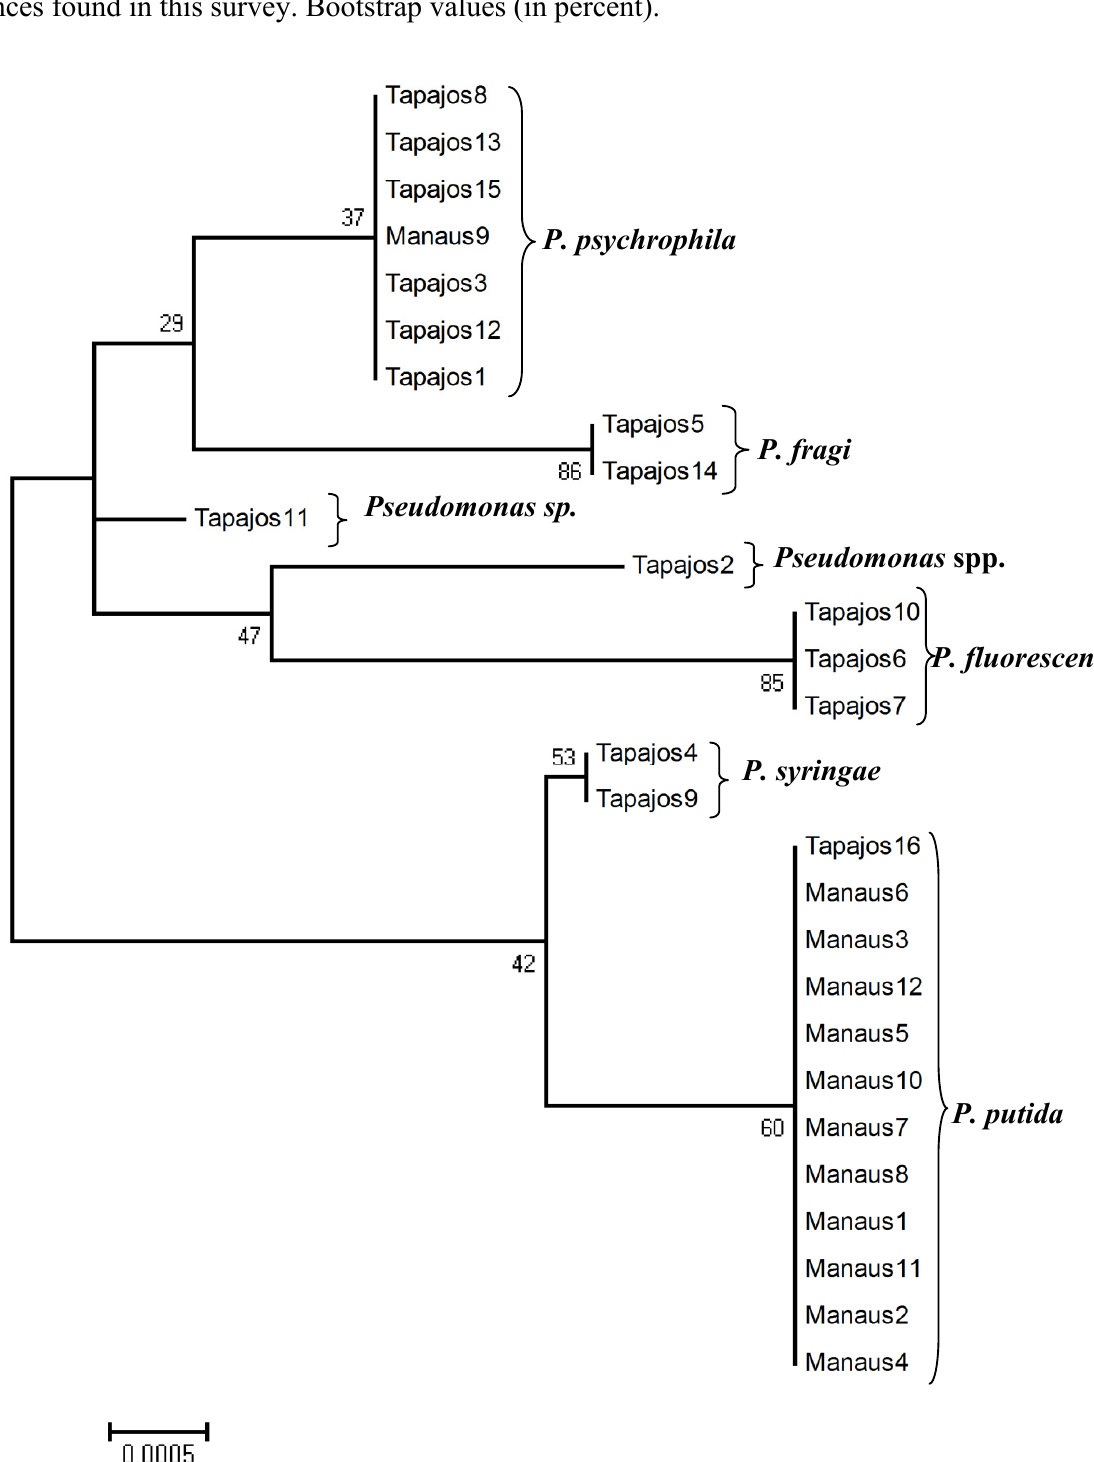
Figure 3. Neighbour-Joining tree constructed based on 16S rDNA Pseudomonas sequences found in this survey. Bootstrap values (in